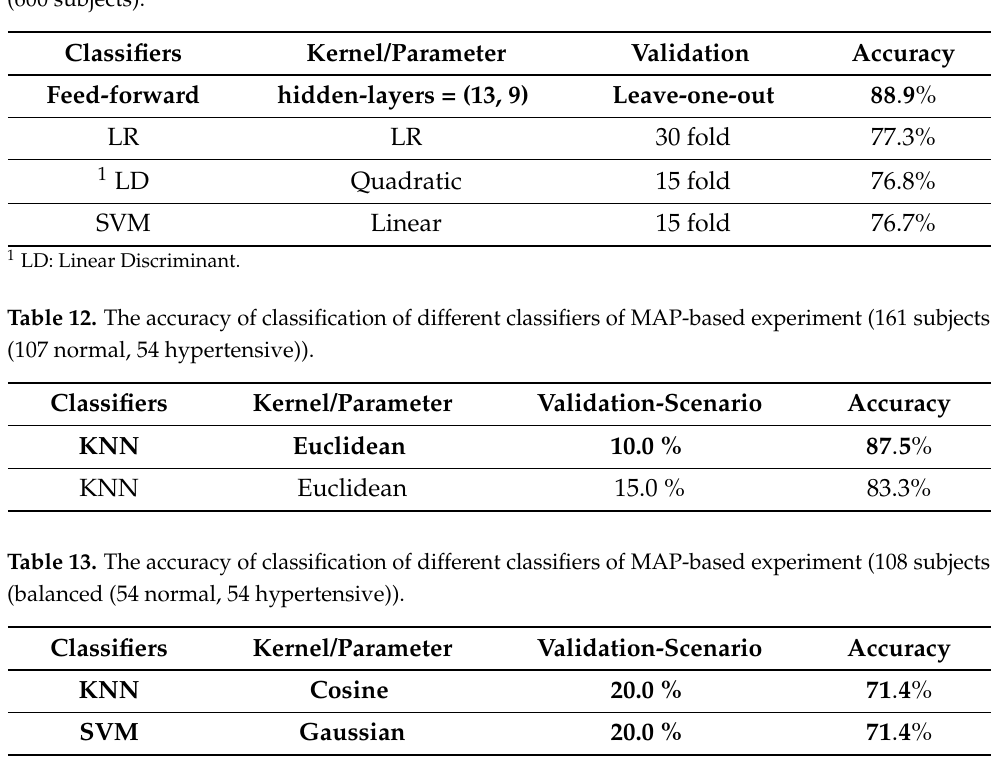
Table 11. The accuracy of classification of different classifiers of the diastolic-based sub-experiment (600 subjects).